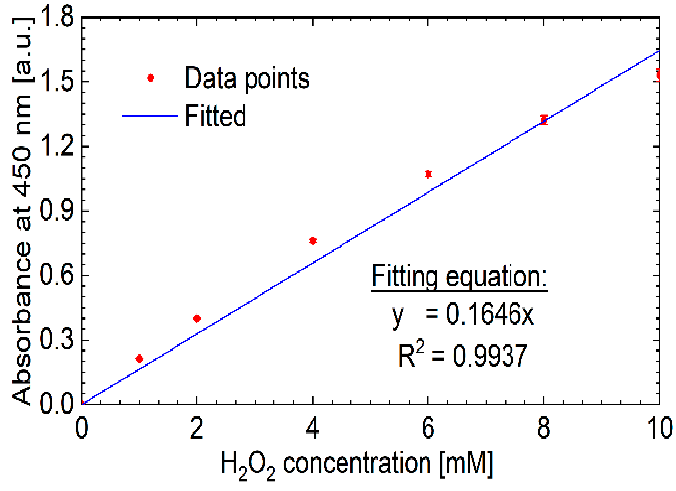
Figure 2. Calibration curve used for calculating the H 2 O 2 concentration in the plasma activated so- lutions using the linear regression equation shown in the graph.